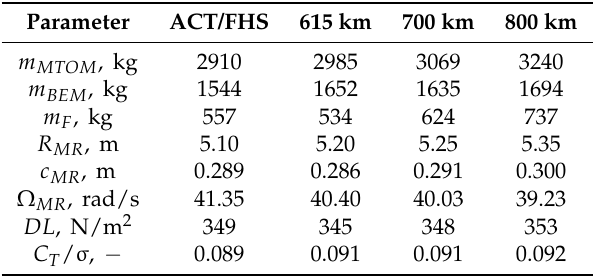
Figure 15. Fuel estimation loop results for different ranges iteration steps. Table 7. Characteristic parameters of the reference and virtual configuration with 3 design ranges.